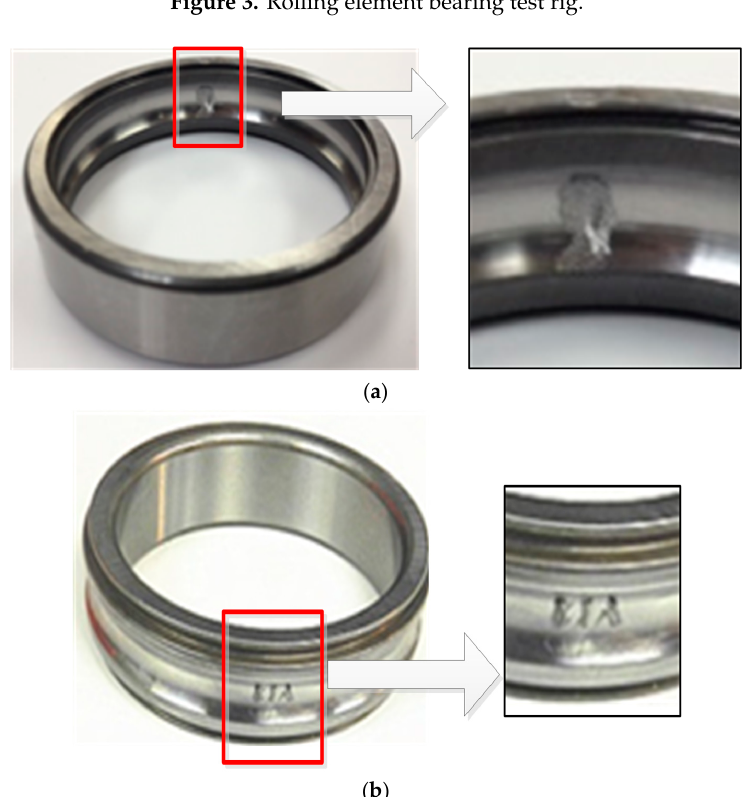
Figure 4. The faulty bearing: ( a ) outer race fault; ( b ) inner race fault.